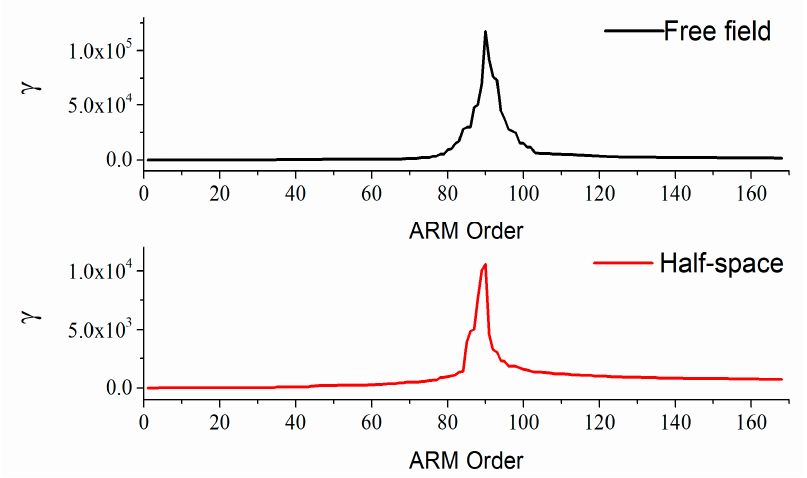
Figure 8 . The variation of 𝛾 with the increase of ARM order when 90 uniform-arranged measure- Figure 8. The variation of γ with the increase of ARM order when 90 uniform-arranged measurement ment points are used. points are used. Table 3. Different acoustic radiation mode (ARM) truncation numbers in compressed modal equivalent source method (CMESM) for 90 measurement points.